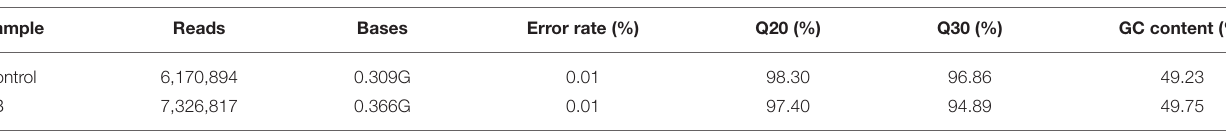
TABLE 2 | Summary statistics of clean reads in CEF transcriptomes in different groups.